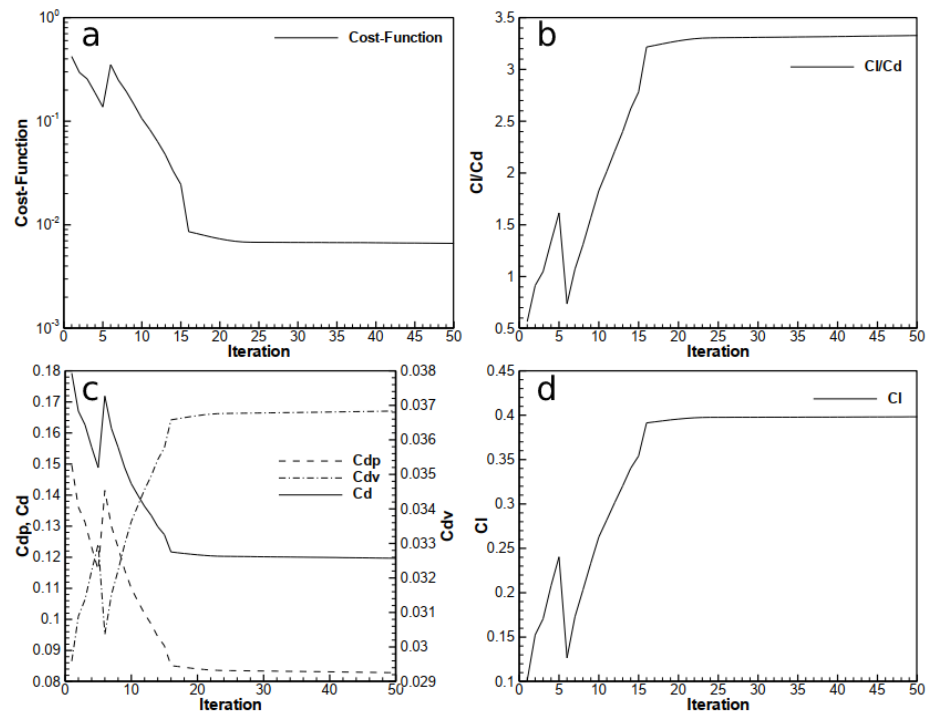
Figure 5. The figures illustrate various aspects of the optimization process of the multipurpose lift-to- drag ratio algorithm. ( a ) Changes in the cost function during the optimization process. ( b ) Represents the lift-to-drag ratio C l / C d obtained after applying the algorithm. ( c ) Shows variations in the pressure drag coefficient C dp , the viscous drag coefficient C dv , and the total drag coefficient C d during the optimization process. Finally, ( d ) displays the changes in the lift coefficient C l during the optimization process.